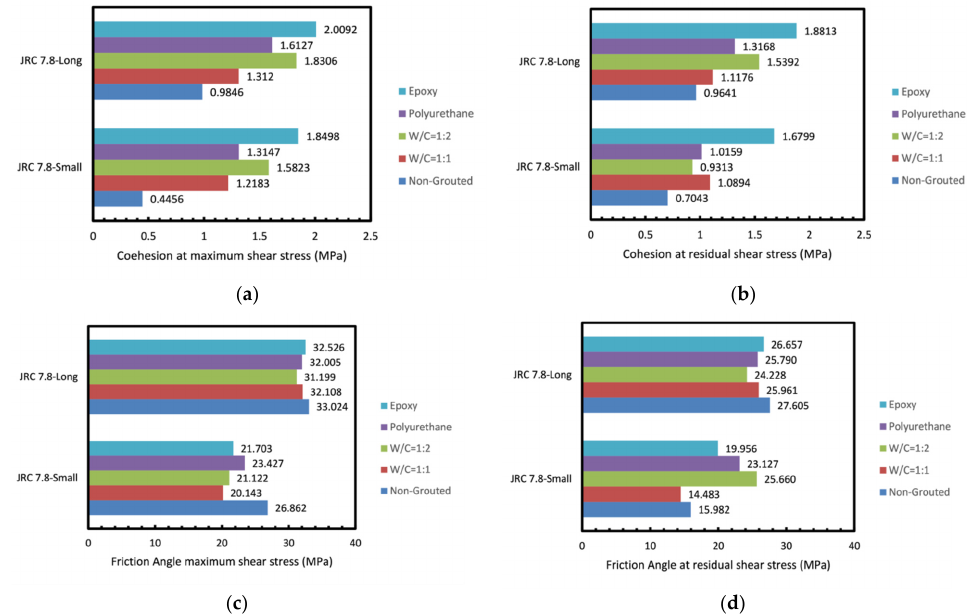
Figure 12. Comparison of the friction angle and cohesion of small and long rock joints tested. ( a , b ) cohesion at maximum and residual shear stress, ( c , d ) friction angle at maximum and residual shear stress.